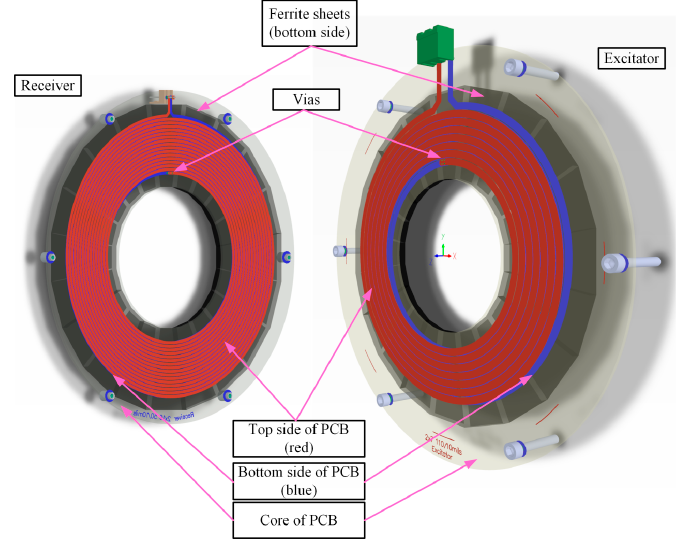
Figure 7. Design view of the proposed CET (left: Receiver coil, right: Excitation coil). Energies 2019 , 12 , x FOR PEER REVIEW